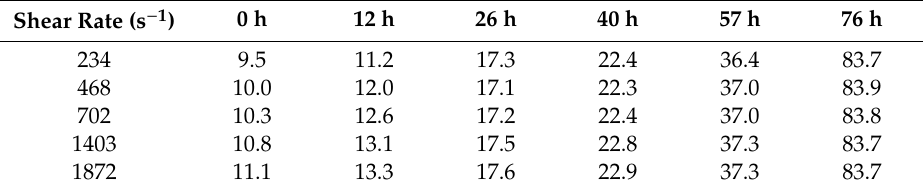
Table 3. Dependence of the dynamic viscosity η (mPa x s) of sunflower oil on the shear rate and time of thermo-oxidative treatment; measuring temperature T = 80 °C.